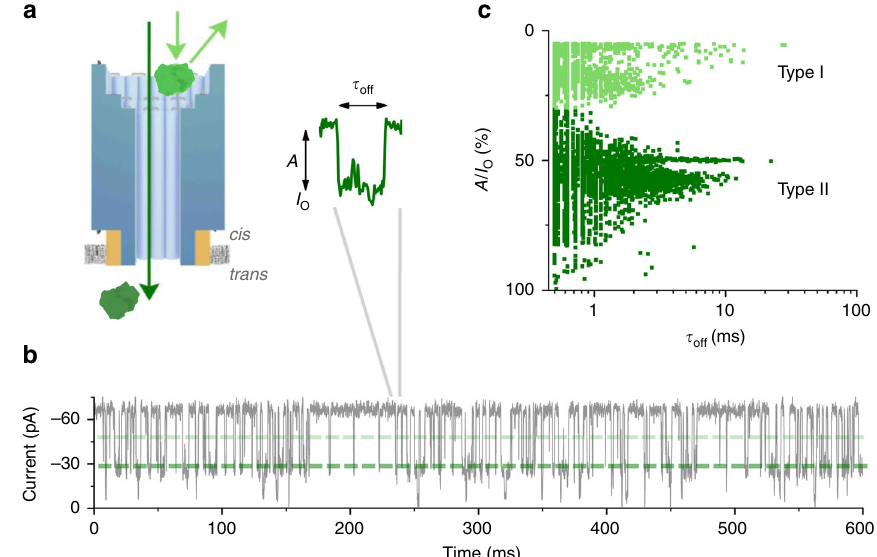
Fig. 4 Transport of protein trypsin through DNA nanopore NP. a Scheme of the DNA nanopore and its interaction with protein molecules (green). b Single- channel current trace recorded at − 50 mV in the presence of trypsin (66.7 µ M) at the cis side leading to blockade. c Scatter plot showing dwell time τ off and amplitude A for single-channel current recordings with trypsin (66.7 μ M) in the cis chamber. Points cluster into type I (light green) and type II (dark green) events. Each point in the diagram represents an individual encounter event of protein with the DNA nanopore. The scatter plot comprises 7282 data points from three independent DNA nanopore insertions. Electrical recordings were measured using the Orbit mini device which is grounded at the trans chamber. Source data are provided as a Source Data fi seen at voltages exceeding 80 mV (Supplementary Fig. 7). The voltage-dependent gating may be caused by partial unzipping of DNA strands 36,49 and could be reduced by forming a more covalently closed nanostructure 52 . The voltage ramps established that the nanopore was of ohmic behaviour; apparently, the structural asymmetry of the pore does not in fl uence voltage- dependent conductance (Fig. 3c).